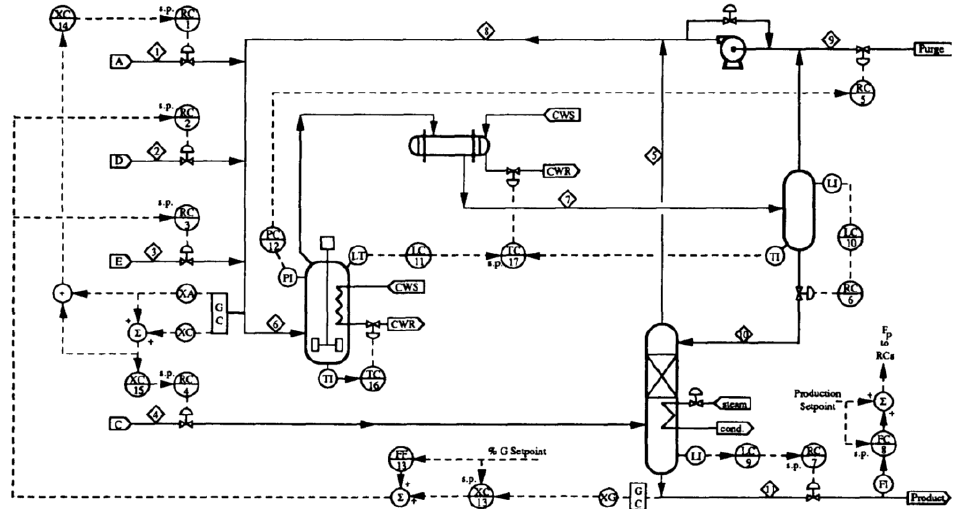
Figure 8. The control system of TEP simulation.